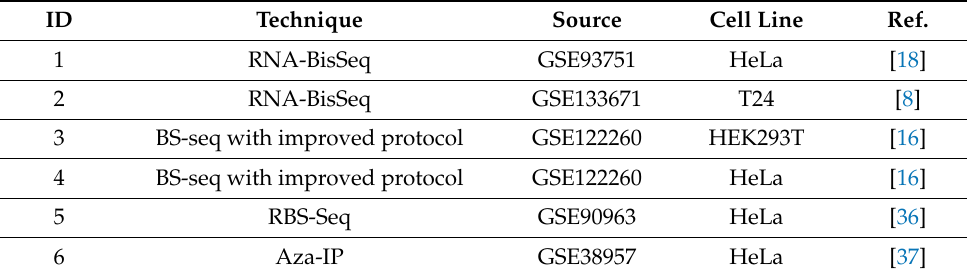
Table 1. Base-resolution datasets of m5C sites.